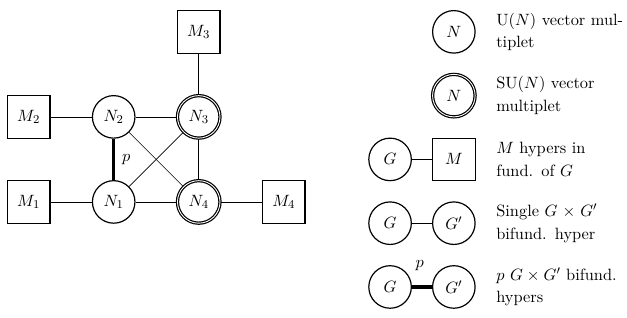
Figure 2 . A quiver gauge theory with G = U( N 1 ) × U( N 2 ) × SU( N 3 ) × SU( N 4 ) and hypermultiplets in bifundamental representations, with the various conventions listed on the r.h.s.